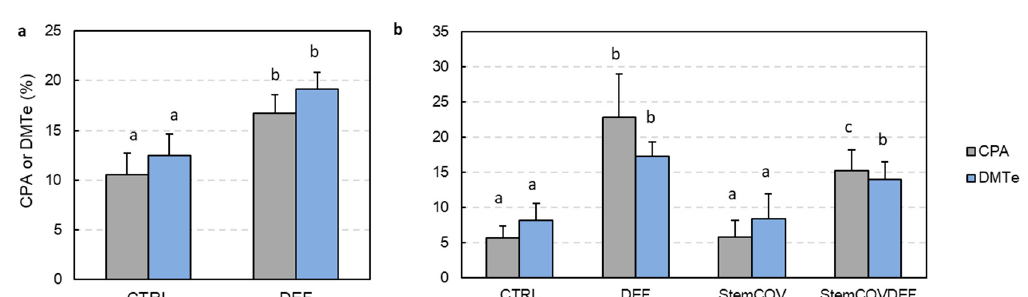
Figure 6. ( a ) Contribution of pre − anthesis reserves to grain weight (CPA, %) ( p < 0.001 for cultivar; p < 0.05 for treatments; p = 0.197 for year and all non − significant interactions, expect for year × treatment p < 0.05) and DM translocation efficiency (DMTe, %) ( p < 0.01 for cultivar; p < 0.01 for treatments; p < 0.01 for year and all non − significant interactions, expect for year × cultivar p < 0.01) for subset 2 (four CIMCOG cultivars) combining years 2013 and 2014 for CTRL and DEF and ( b ) CPA ( p < 0.01 for cultivar, p < 0.01 for treatment and p = 0.237 for cultivar × treatment interaction) and DMTe ( p < 0.01 for cultivar, p < 0.05 for treatment and p = 0.991 for cultivar × treatment interaction) for subset 2